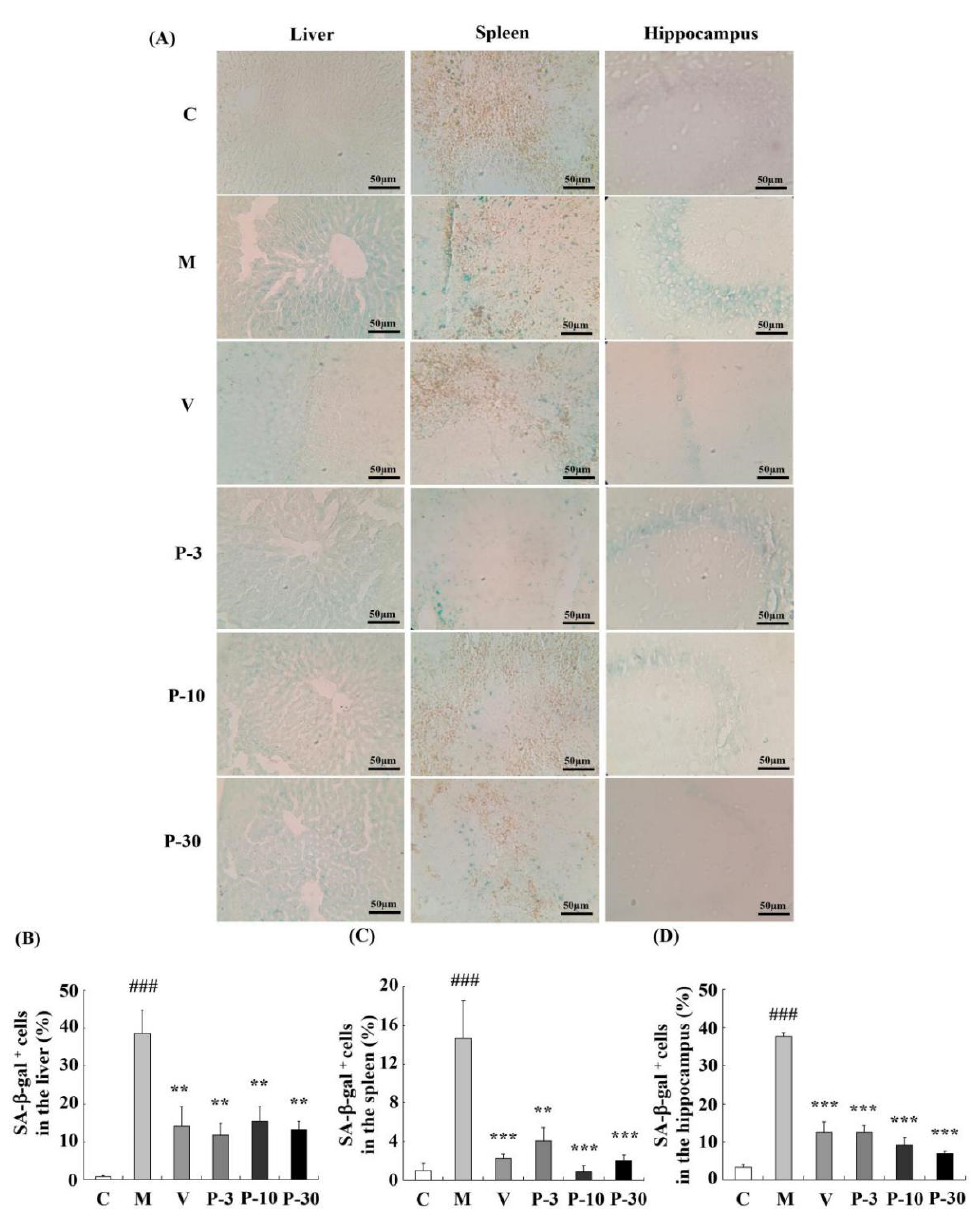
Figure 7. PAE e ff ects on the activity of SA- β -gal in the liver, spleen, and brain. ( A ) The representative Figure 7. PAE effects on the activity of SA-β-gal in the liver, spleen, and brain. ( A ) The representative image of SA- β -gal staining in each group was captured (magnification 400 × ). ( B – D ) Quantification of image of SA-β-gal staining in each group was captured (magnification 400×). ( B , C , and D ) the percentage of SA- β -gal-positive cell numbers in the liver, spleen, and hippocampus. Blue staining Quantification of the percentage of SA-β-gal-positive cell numbers in the liver, spleen, and stands for SA- β -gal-positive cells. The data are expressed as mean ± SEM, n = 6. ### p < 0.001 indicate hippocampus. Blue staining stands for SA-β-gal-positive cells. The data are expressed as mean ± SEM, significant di ff erence compared with the control group; ** p < 0.01, and *** p < 0.001 indicate significant di ff erence compared with the d -gal-treated group. C, control group, C received saline; M, d -gal model group, M received 150 mg / kg d -gal; V, 100 mg / kg VE group, it received 100 mg / kg VE + 150 mg / kg d -gal; P-3, 3 mg / kg PAE group, it received 3 mg / kg PAE + 150 mg / kg d -gal; P-10, 10 mg / kg PAE group, it received 10 mg / kg PAE + 150 mg / kg d -gal; P-30, 30 mg / kg PAE group, it received 30 mg / kg PAE + 150 mg / kg d